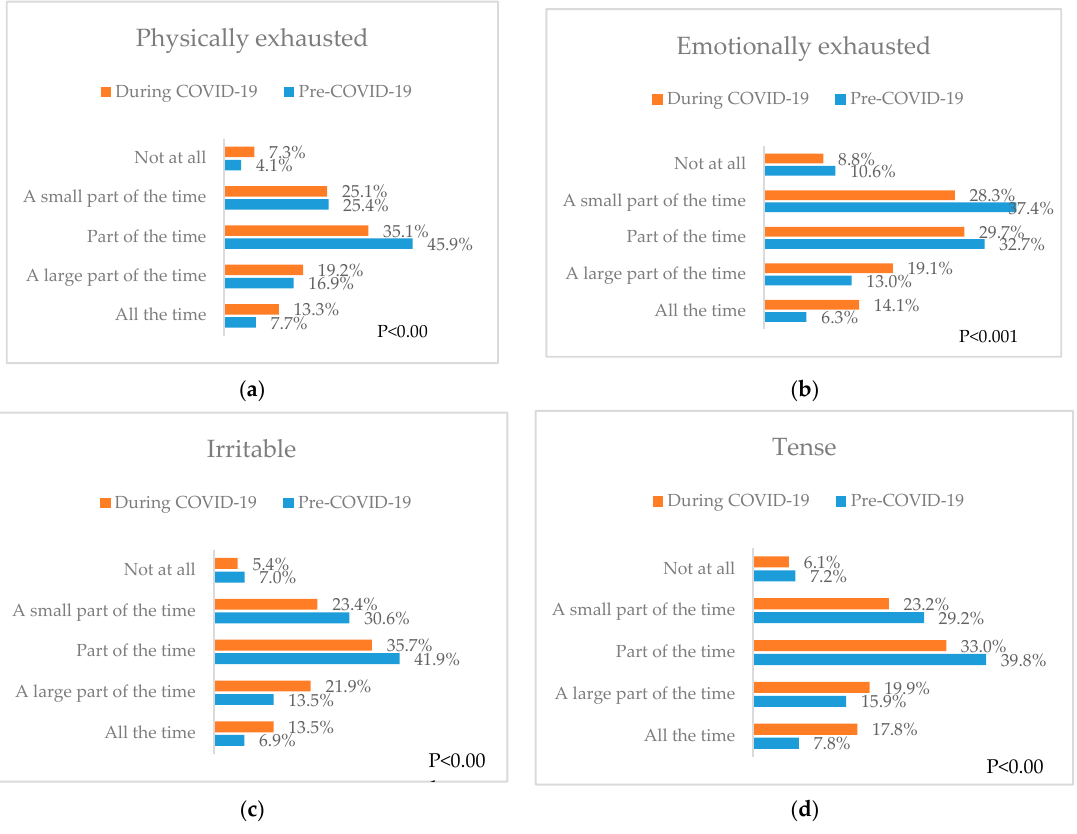
Figure 2. Stress and irritability pre- and during COVID-19 pandemic ( a ) Physical exhaustion; ( b ) Emotional exhaustion; ( c ) Irritability; ( d ) Tension. The p values indicate the statistical significance of McNemar test.